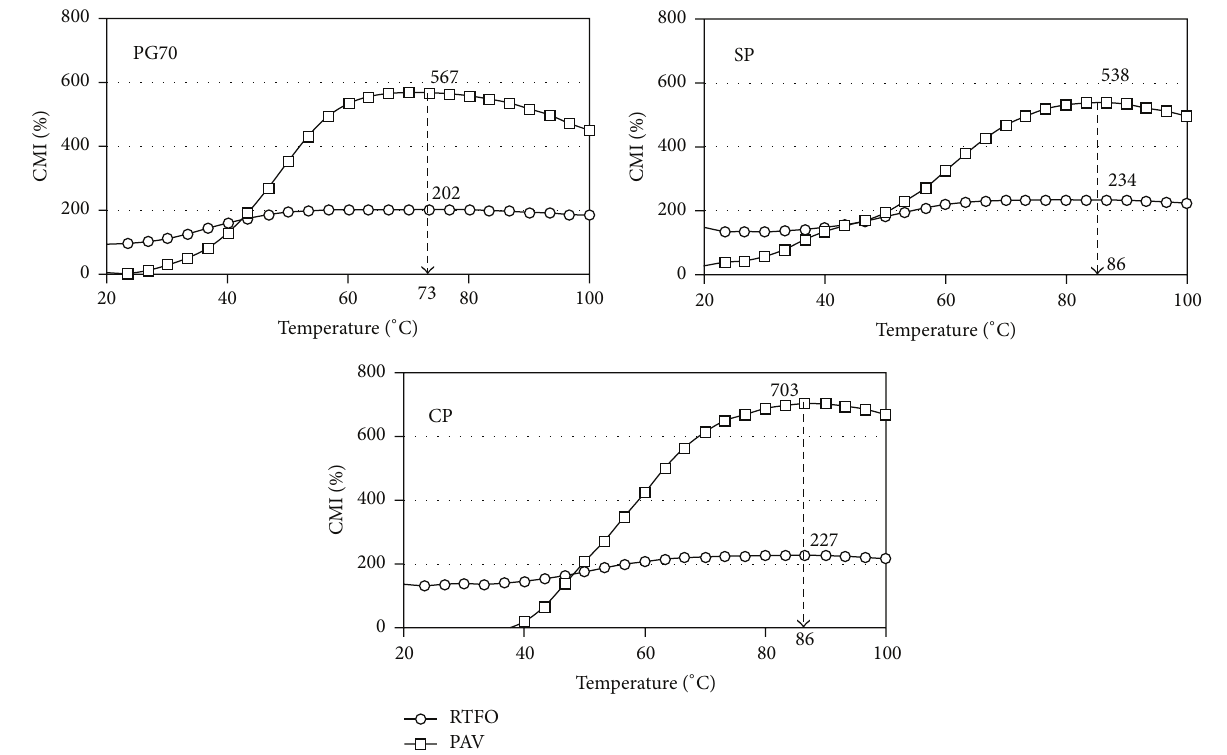
Figure 3: CMI showing the critical stiffness temperatures of